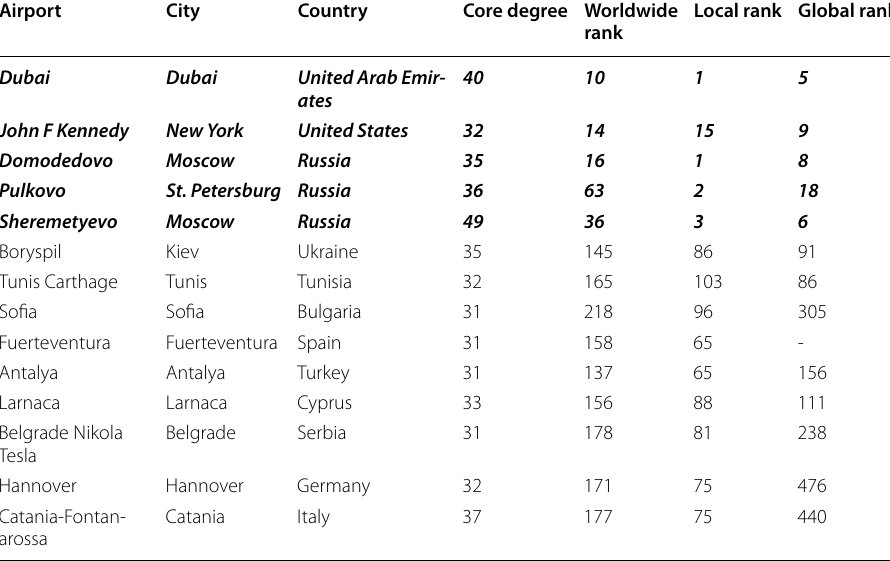
Airports in the European local component are in black. Airports from other local components are in bolditalic. The core degree is the number of links in the maximum k-core network. Worldwide rank is the rank in the world air transportation network. Local rankis the rank in the large local components. Global rank is the rank in the global component